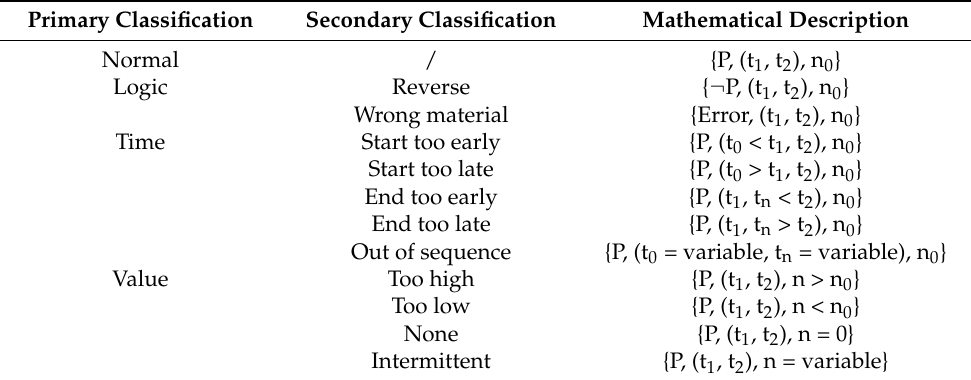
Table 2. Mathematical description of failure